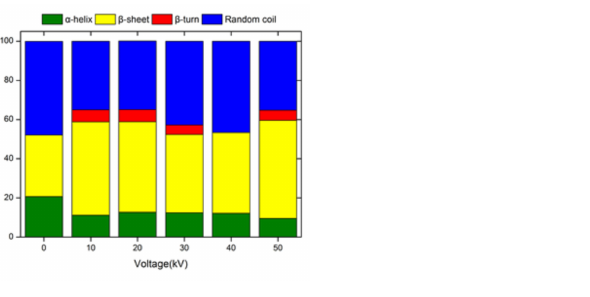
Figure 7. Effect of different ACP treatment voltage on the secondary structure of trypsin, 0 kV refers to control samples without ACP